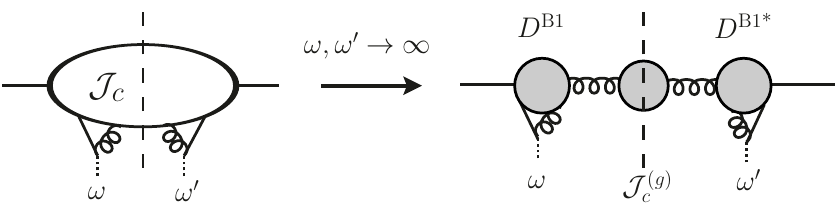
Figure 4 . Factorization of the radiative collinear function J c ( p 2 , ω, ω 0 ) , which appears in the A- type term, in the limit ω, ω 0 → ∞